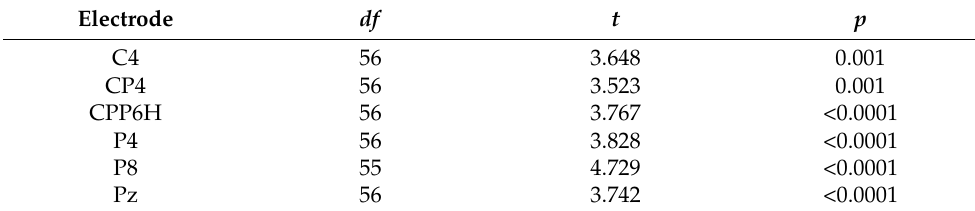
Figure 7. EEG results in the 260–300 ms time window, showing significant channels for both groups (patients and controls merged). The analogical curve progression of both groups is illustrated by the enlarged time course of the P4 channel. Negativity is plotted upwards. Table 3. Results of post-hoc t -tests comparing congruency levels for time window 260–300 ms merged across both